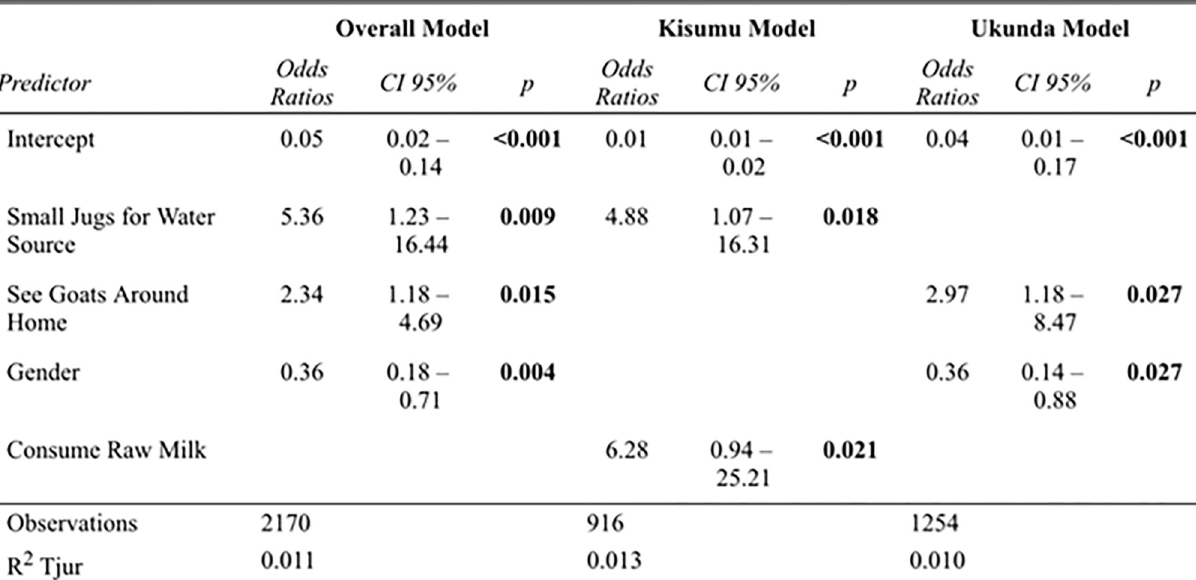
retained in the initial model. However, variables to determine water source, the availability of piped water and the use of a small water jugs, were highly negatively correlated (r (3,558) = -0.43, p < 0 . 002 ) and the use of small jugs having the more significant p-value in bivariate anal- ysis was chosen for inclusion in model building.